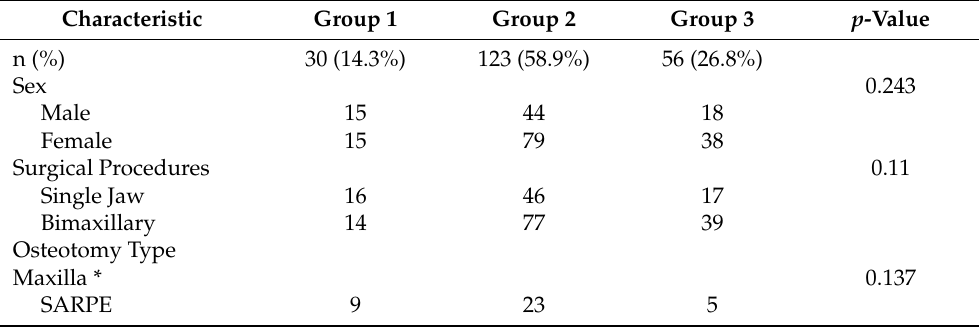
Table 2. Demographic and clinical data of the study